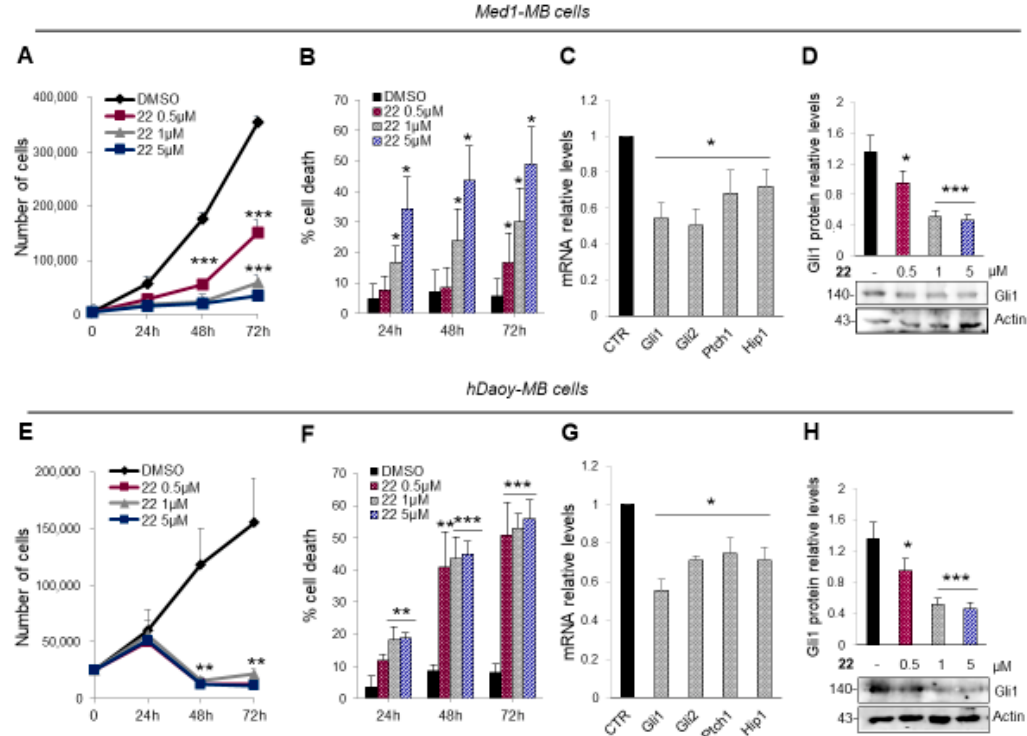
Figure 6. Mouse Med1-MB ( A – D ) and human Daoy MB ( E – H ). Cells were treated with compound 22 (0.5, 1 and 5 µM) or DMSO only. After the indicated times, a trypan blue count was performed to determine the growth rate of viable cells and the percentage of cell death ( A , B and E , F ). mRNA expression levels of the Hh target genes ( C , G ) and Gli1 protein levels with the corresponding densitometric analysis ( D , H ) were shown. Data show the mean ± SD of three independent experiments. (*) p < 0.05 vs. DMSO; (**) p < 0.01 vs. DMSO; (***) p < 0.001 vs. DMSO.